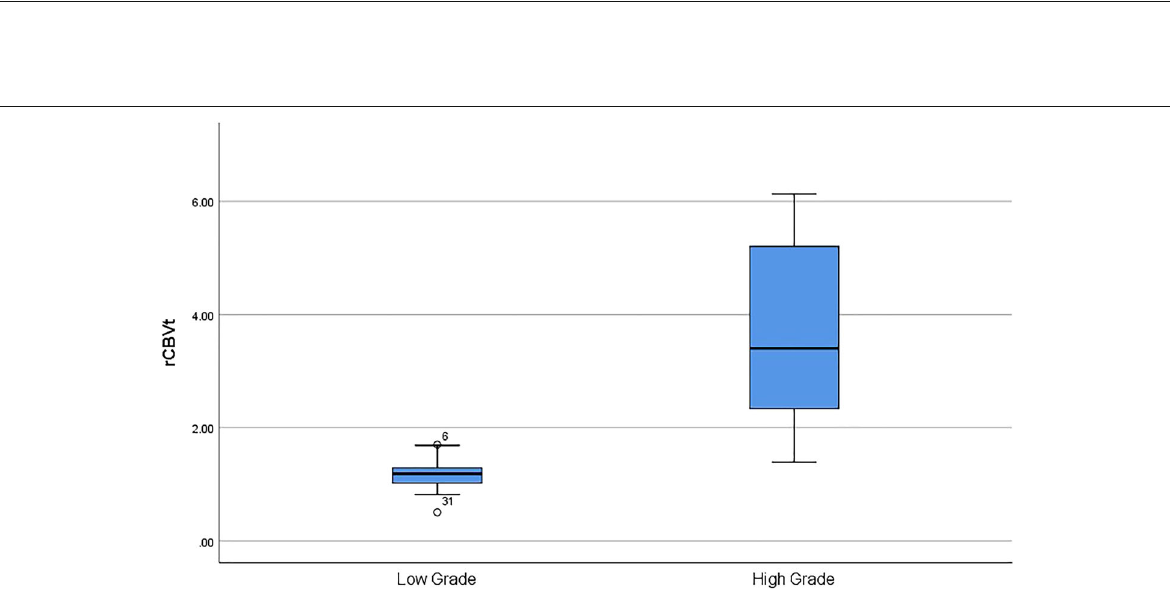
Fig. 3 Box plot for rCBVt between HG and